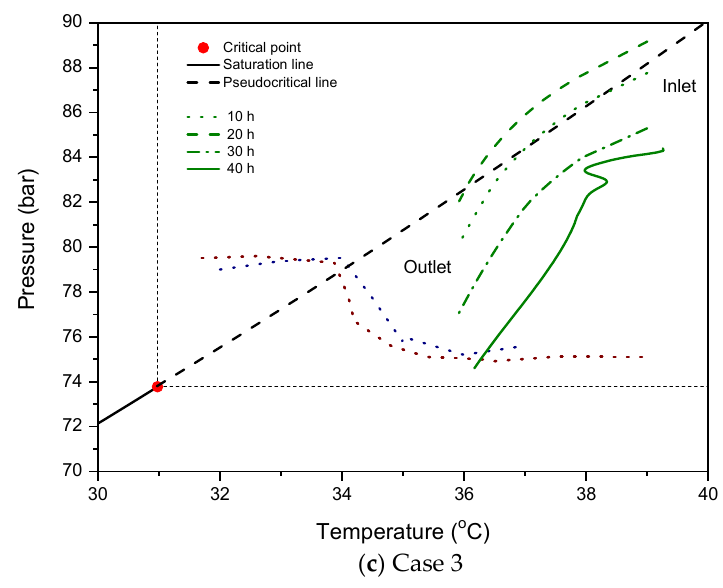
Figure 13. Pressure–temperature profile of the horizontal pipeline.